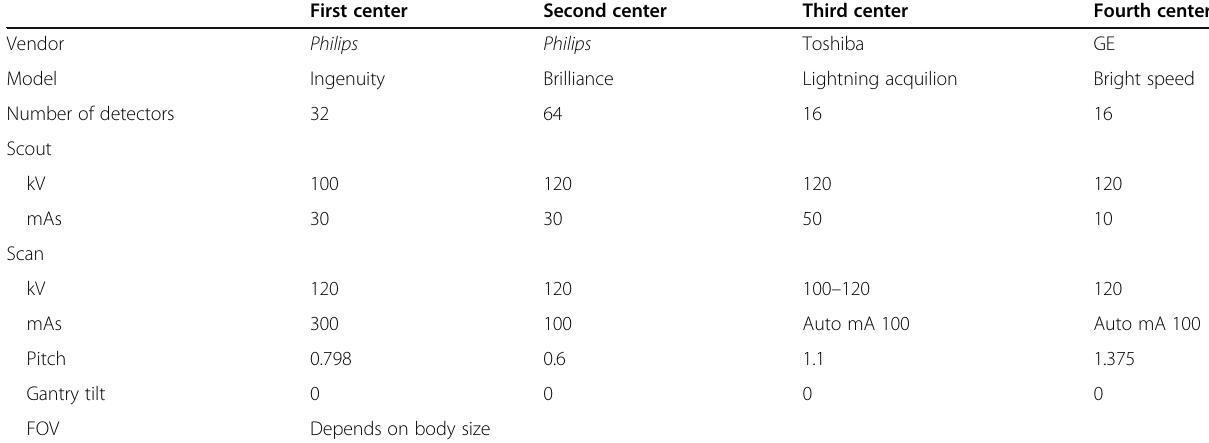
Table 1 Technical parameters employed in chest imaging within the multiple centers